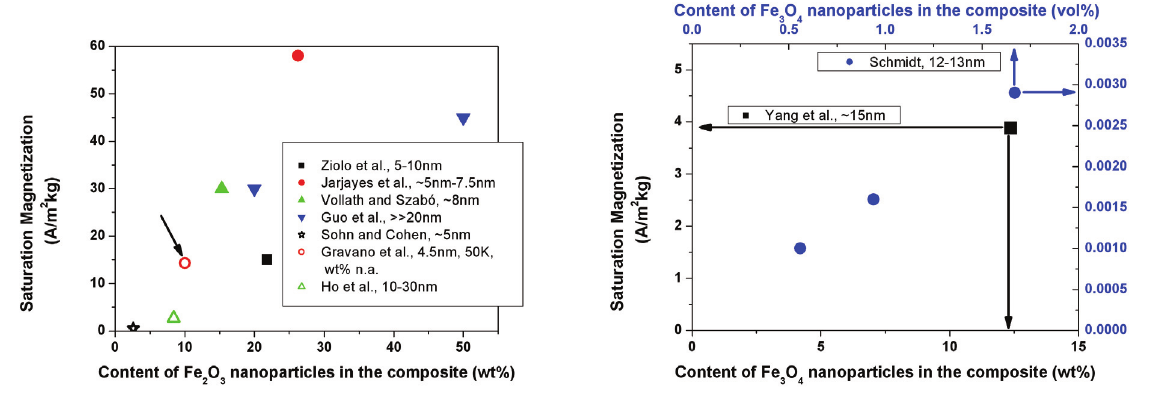
Figure 9. Saturation magnetization of different nanocomposites, containing either Fe (left) or Fe O (right) nanoparticles as magnetic active material, plotted as a function of 3 4 nanoparticle content. Experimental data are taken from Ziolo et al. [75,76], Jarjayes et al. [156], Vollath and Szabó [89], Guo et al. [157], Sohn and Cohen [158], Gravano et al. [55], Ho et al. [61], Yang et al. [64] and Schmidt [53]. All data are, with exception of those from Gravano et al. , acquired at room temperature. This data point (left image) is marked with an arrow, as also composition is unclear. The right image shows two x-axes, one in wt %, and the other in vol %. The y-axes are both saturation magnetization, but with different